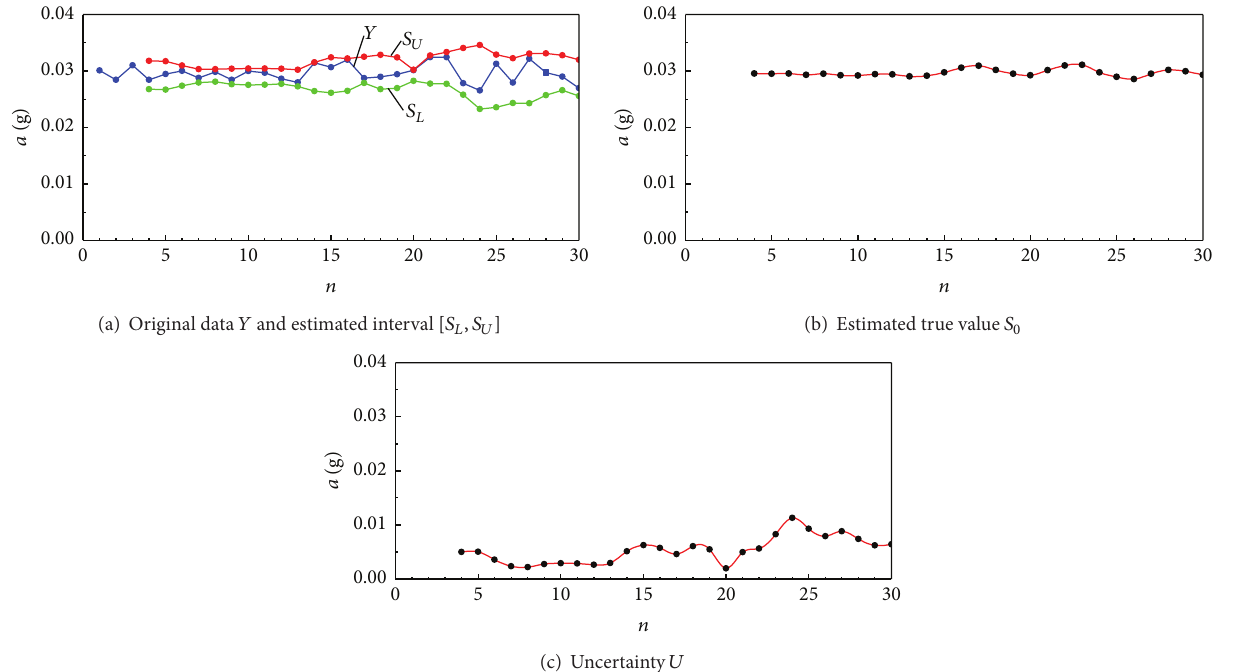
Figure 8: Dynamic evaluation for vibration acceleration of gearbox with modification